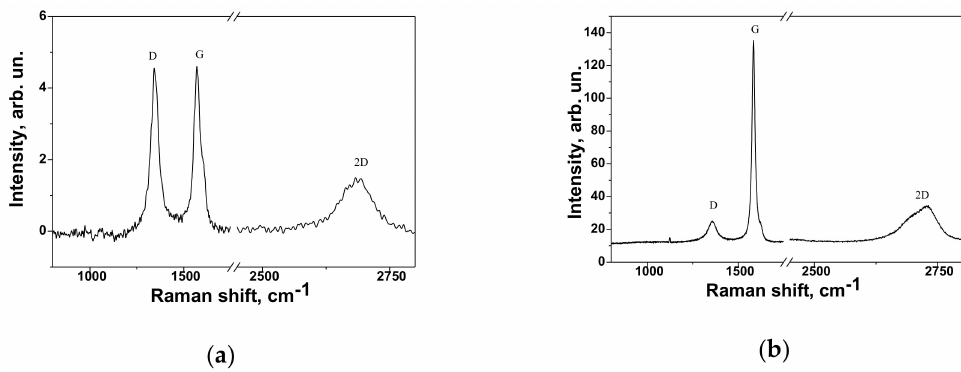
Figure 3. Raman spectra of MWCNTs ( a ) and EG ( b